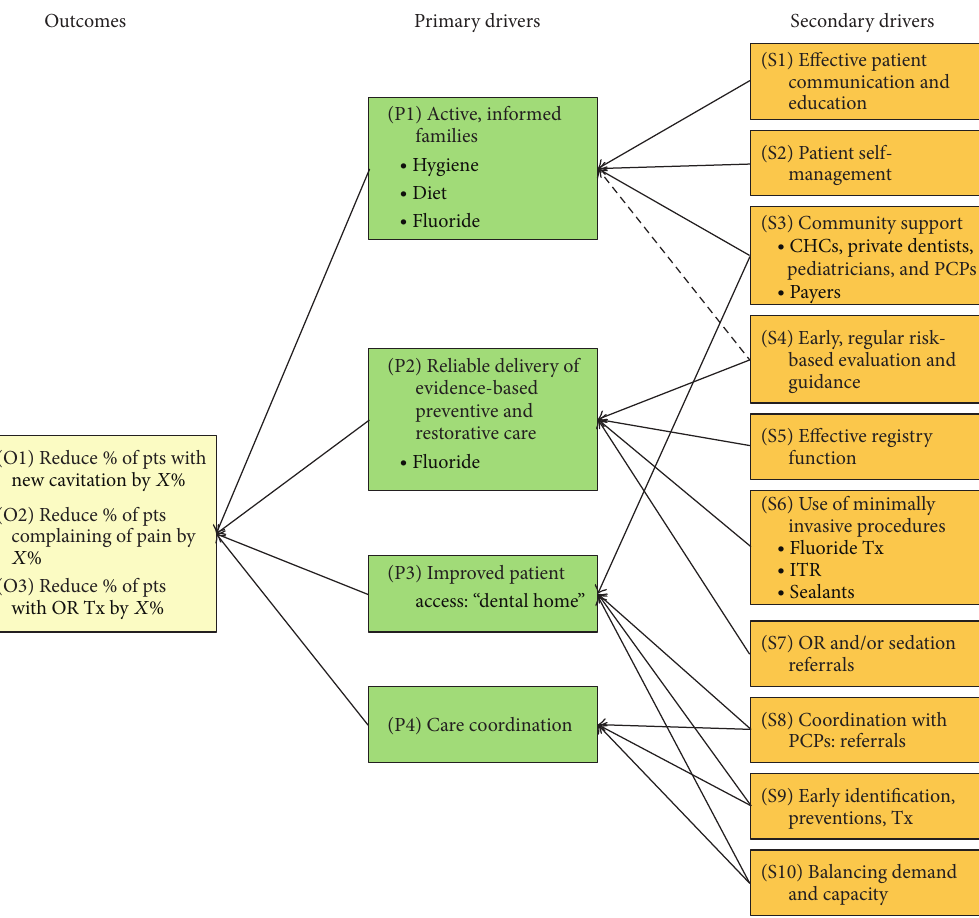
Figure 1: ECC Phase 2 Driver